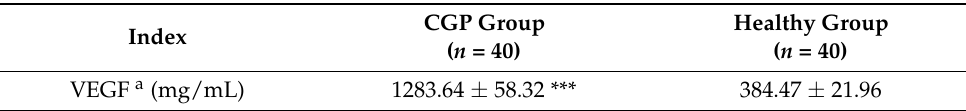
Table 3. Level of vascular endothelial growth factor (VEGF) in saliva in patients with chronic generalized periodontitis.